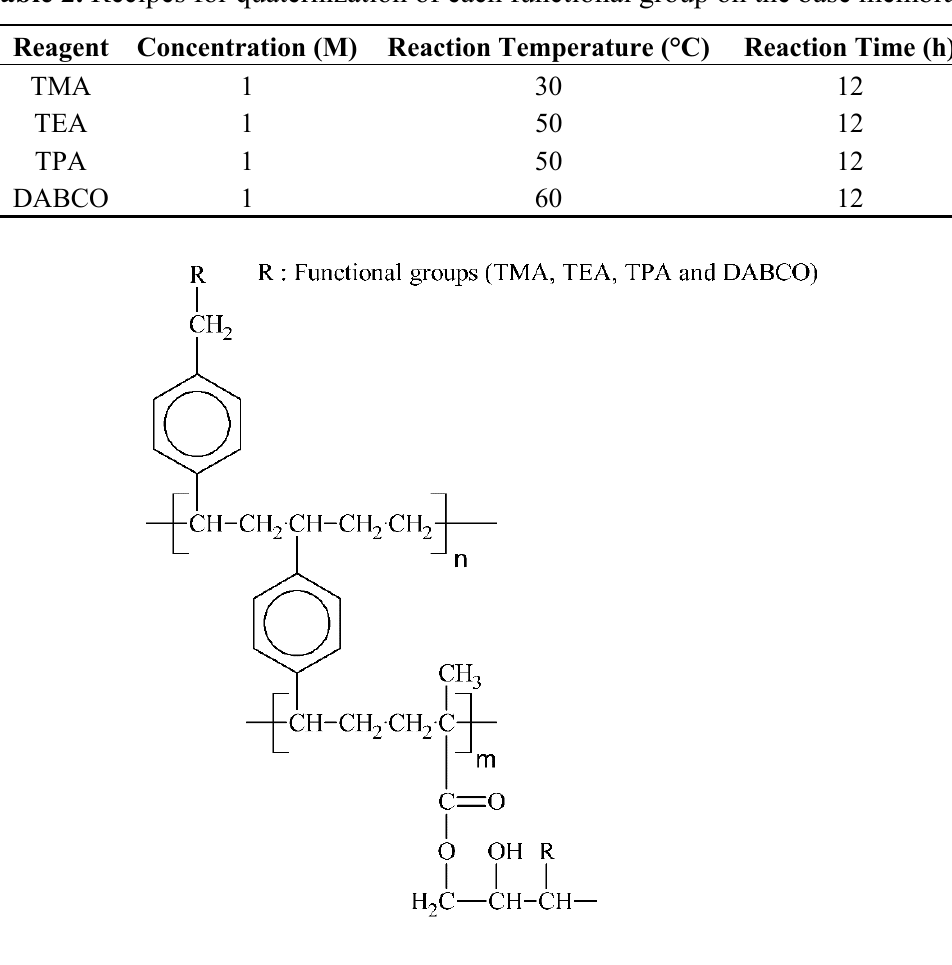
Figure 1. Chemical structure of GDV45 membranes based on different functional